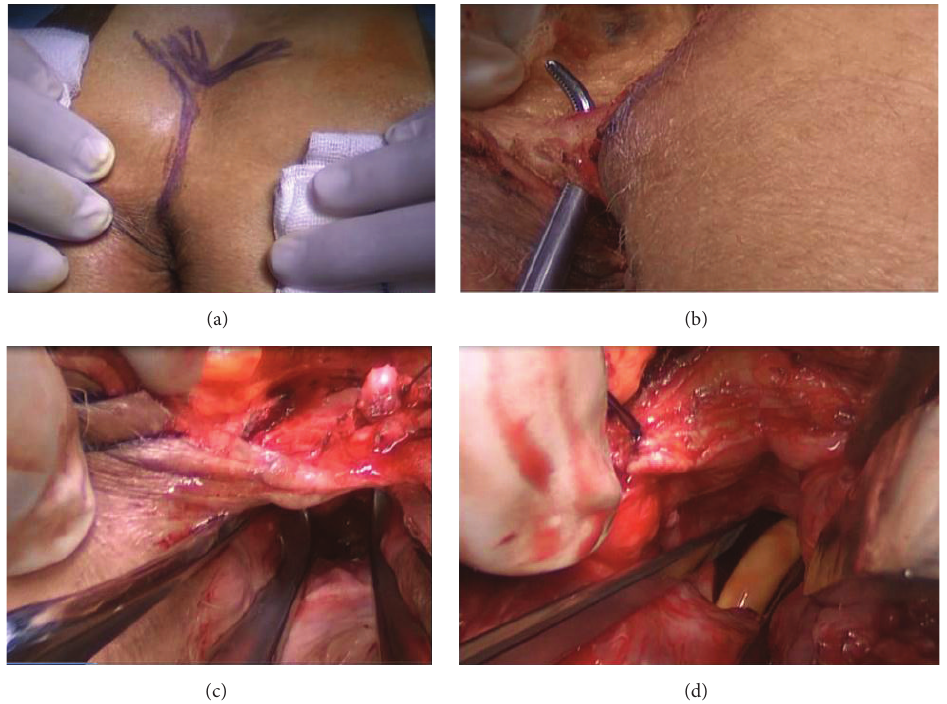
Figure 3: Pictures showing the opening of the posterior rectal wall; it is first part of the York Mason posterior transrectal transsphincteric procedure. (a) Incision line is seen. (b) After opening skin and subcutaneous tissue, gluteus and anal sphincter muscles are seen. (c) Incised anal sphincter muscles and posterior rectal wall are seen. (d) After opening posterior rectal wall, the rectourethral fistula (RUF) and urethral catheter are seen.